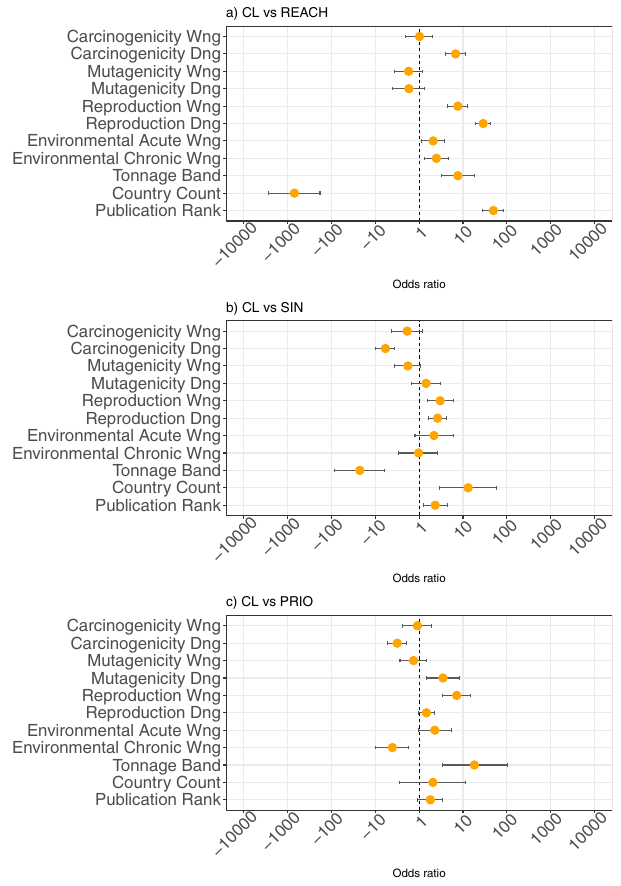
Fig. 3 | Marginal contribution of carcinogenicity, mutagenicity, reproductive toxicity, and environmental properties to the odds of inclusion on the Candidate List. The fi gure presents the point estimates of the odds ratio and the corresponding 95% con fi dence interval for all parameters included in the logit model where we explore in further detail which speci fi c toxicological properties affect the listing on the Candidate List. Chemicals listed in the Candidate List are compared to ( a ) all chemicals registered under the European chemical regulation Registration, Evaluation, Authorization, and Restriction of Chemicals (REACH, n =15,169),( b )chemicalslistedontheSINlist(SIN, n =874),and( c )chemicalslisted onthePRIOlist(PRIO, n =856).Parameterswithestimatestotheleftofthevertical line at 1willtypically be of lowervalue inthe CandidateListascompared to the list with which it is compared, and vice